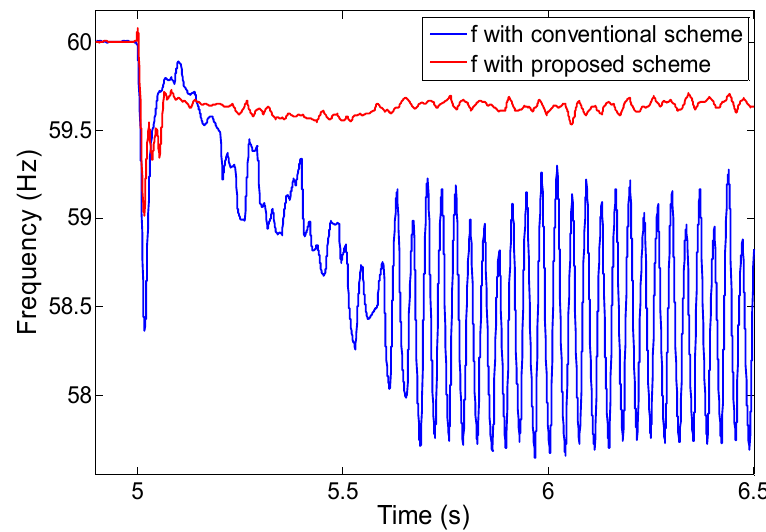
Figure 28. Comparison of the frequency responses using the conventional and the proposed droop control scheme.